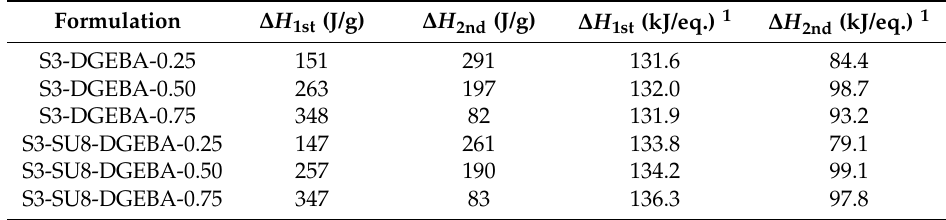
Table 2. Reaction heat of the first and second polymerization processes corresponding to the curing of S3-DGEBA and S3-SU8-DGEBA formulations with a thiol: epoxy ratios of 0.25, 0.50 and 0.75. Formulation ∆ H 1st (J/g) ∆ H 2nd (J/g) ∆ H 1st (kJ/eq.) 1 ∆ H 2nd (kJ/eq.) 1 S3-DGEBA-0.25 151 263 147 S3-SU8-DGEBA-0.50 257 190 134.2 99.1 S3-SU8-DGEBA-0.75 347